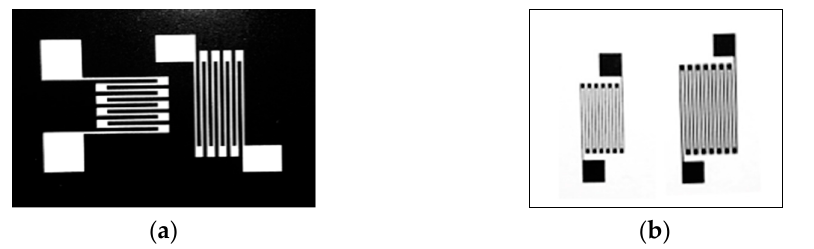
Figure 3. Photolithography process mask. ( a ) Film paper used in PMS. ( b ) Film paper used in PIBE.